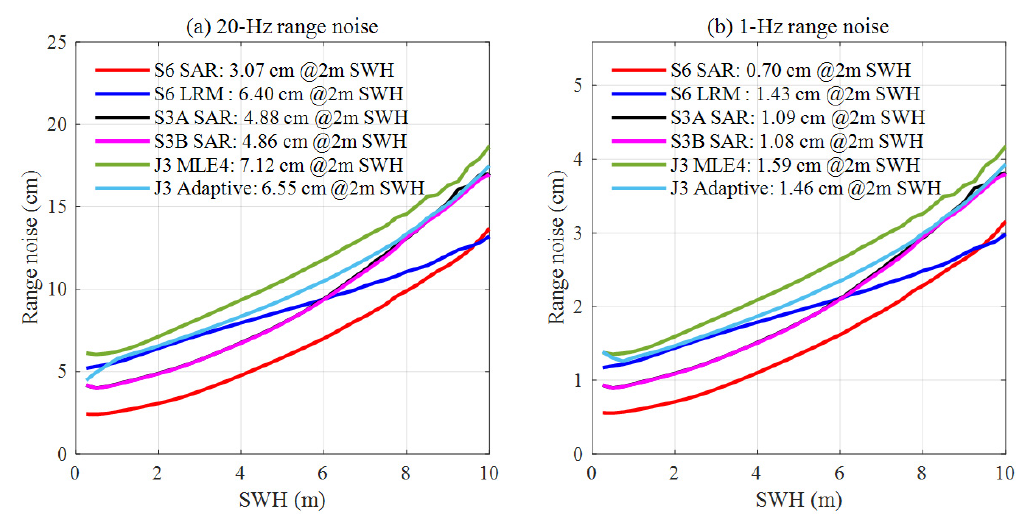
Figure 2. Sentinel-6 ( a ) 20 Hz and ( b ) 1 Hz range noises and their comparisons with Sentinel-3A/B and Jason-3